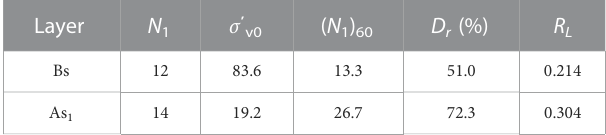
TABLE 2 Calculated liquefaction strength for Bs and As 1 layers.